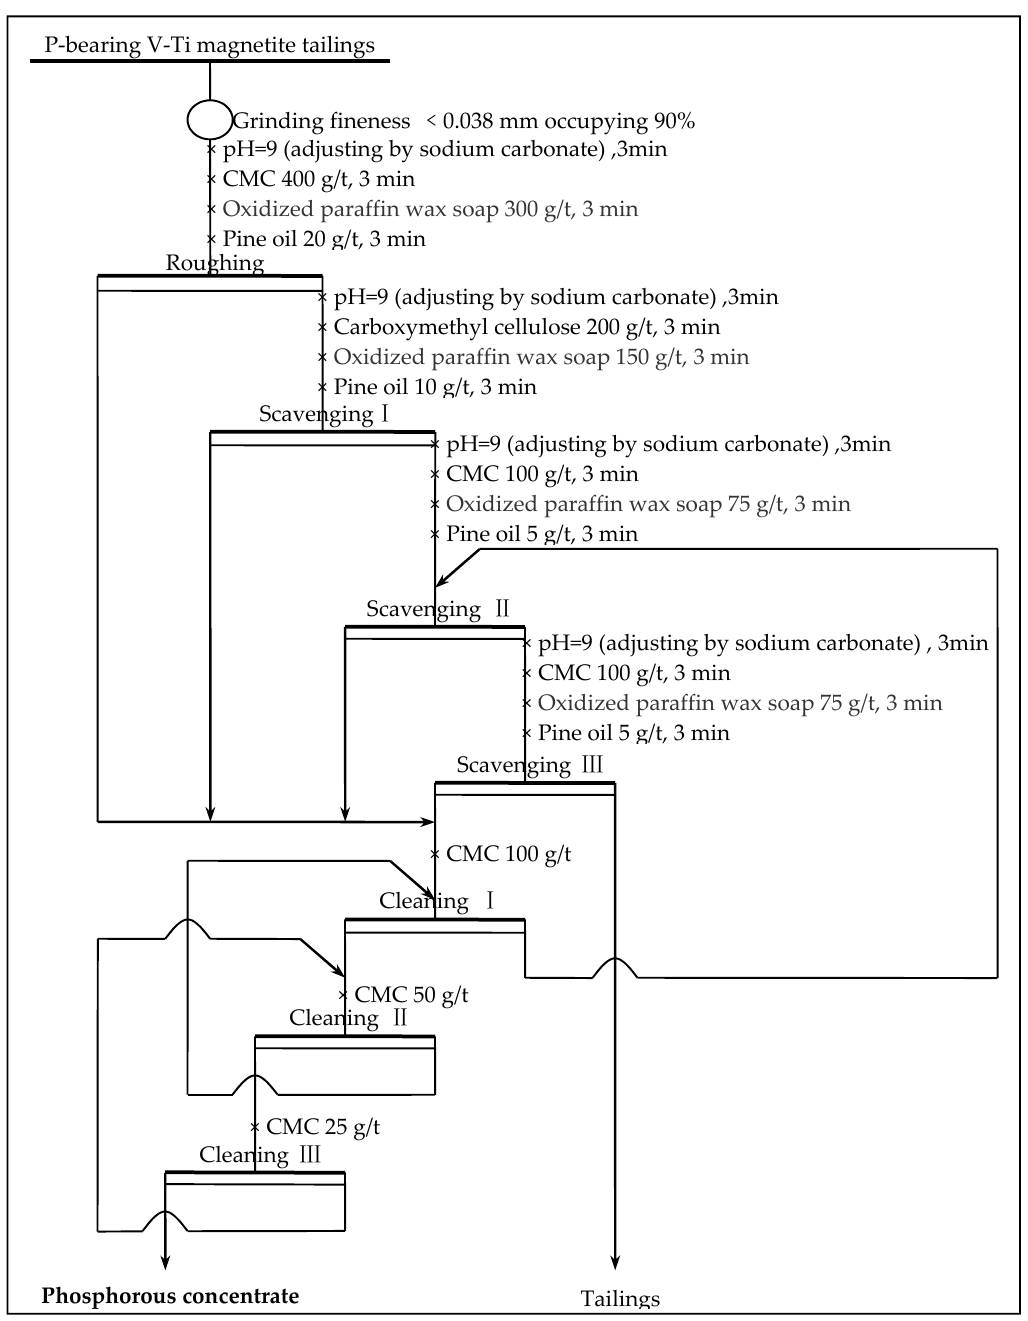
Figure 12. The whole direction flotation flowsheet of recovering phosphorous.